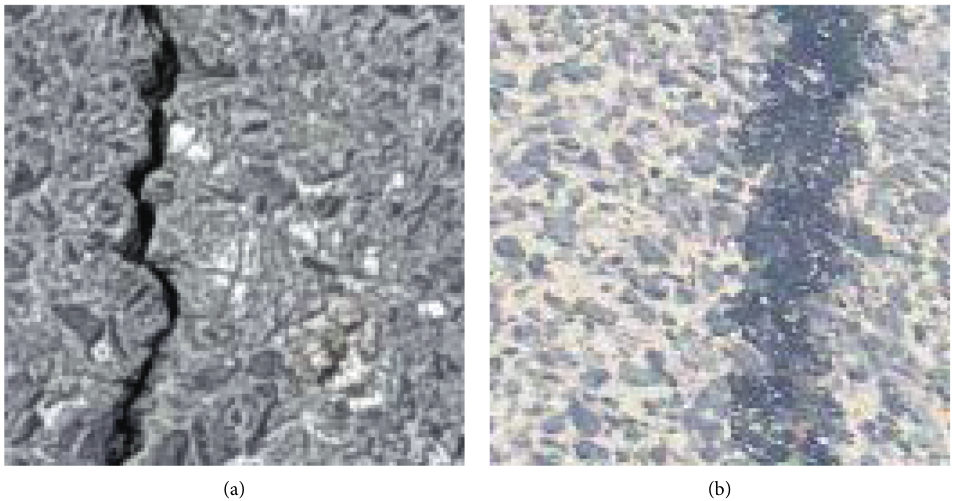
Figure 1: Crack and sealed crack objects found on asphalt pavement surfaces. (a) Crack and (b) Sealed